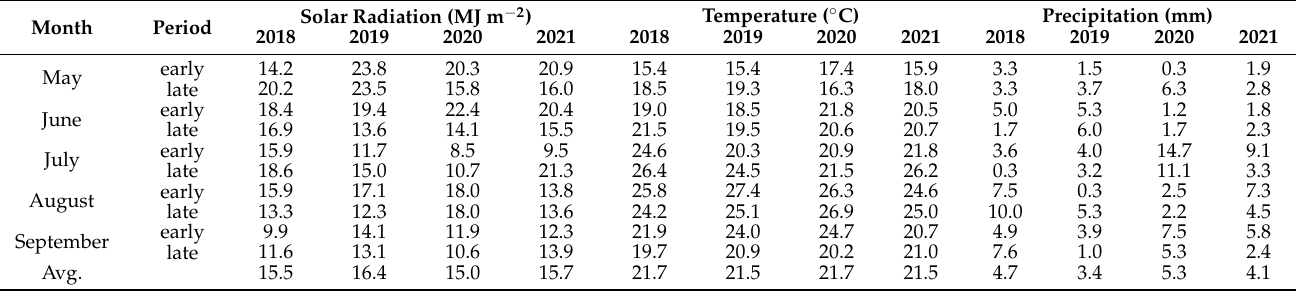
Table 2. Daily average (Avg.) solar radiation (MJ m − 2 ), temperature ( ◦ C) and precipitation (mm) during the growing periods in 2018, 2019, 2020, and